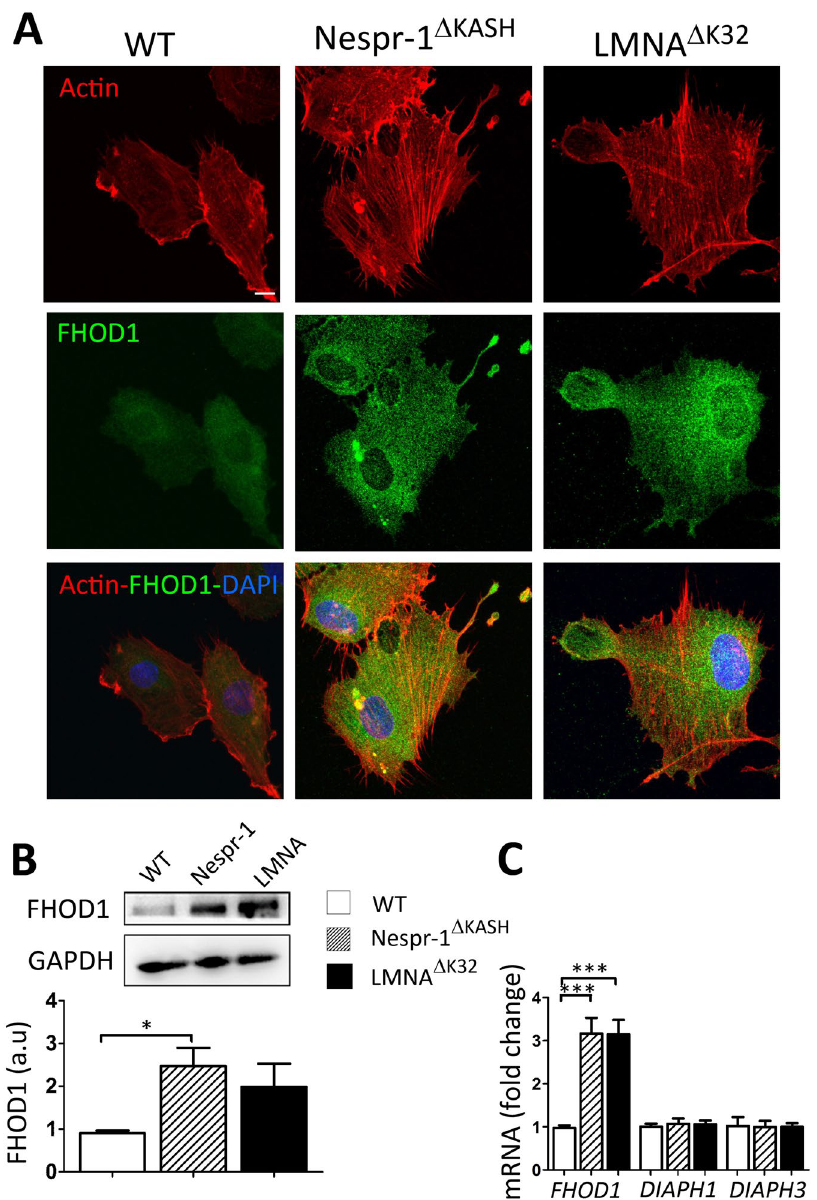
Figure 5. FHOD1 expression in myoblasts on soft matrix (12 kPa). ( A ) Confocal images of WT, Nespr-1 Δ KASH and LMNA Δ K32 myoblasts on soft matrix and stained for F-actin (phalloidin, red) and FHOD1 (green). Nuclei are stained with DAPI (blue). ( B ) Representative western-blot of FHOD1 in WT, Nespr-1 Δ KASH and LMNA Δ K32 myoblasts cultured on soft substrates. Histogram represents FHOD1 quantifications obtained in WT, Nespr- 1 Δ KASH and LMNA Δ K32 myoblasts and normalized by GAPDH. Values are means ± SEM, n = 6 in WT, Nespr- 1 Δ KASH and LMNA Δ K32 myoblasts; * p < 0.05. Only significant difference is figured; au: arbitrary units. ( C ) Histogram represent mRNA concentrations of FHOD1 , DIAPH1 and DIAPH3 normalized to β 2 microglobulin expression and expressed in arbitrary units (au). Values are means ± SEM, n = 5 in WT, Nespr-1 Δ KASH and LMNA Δ K32 myoblasts, *** p < 0.001 compared with WT. Only significant difference is